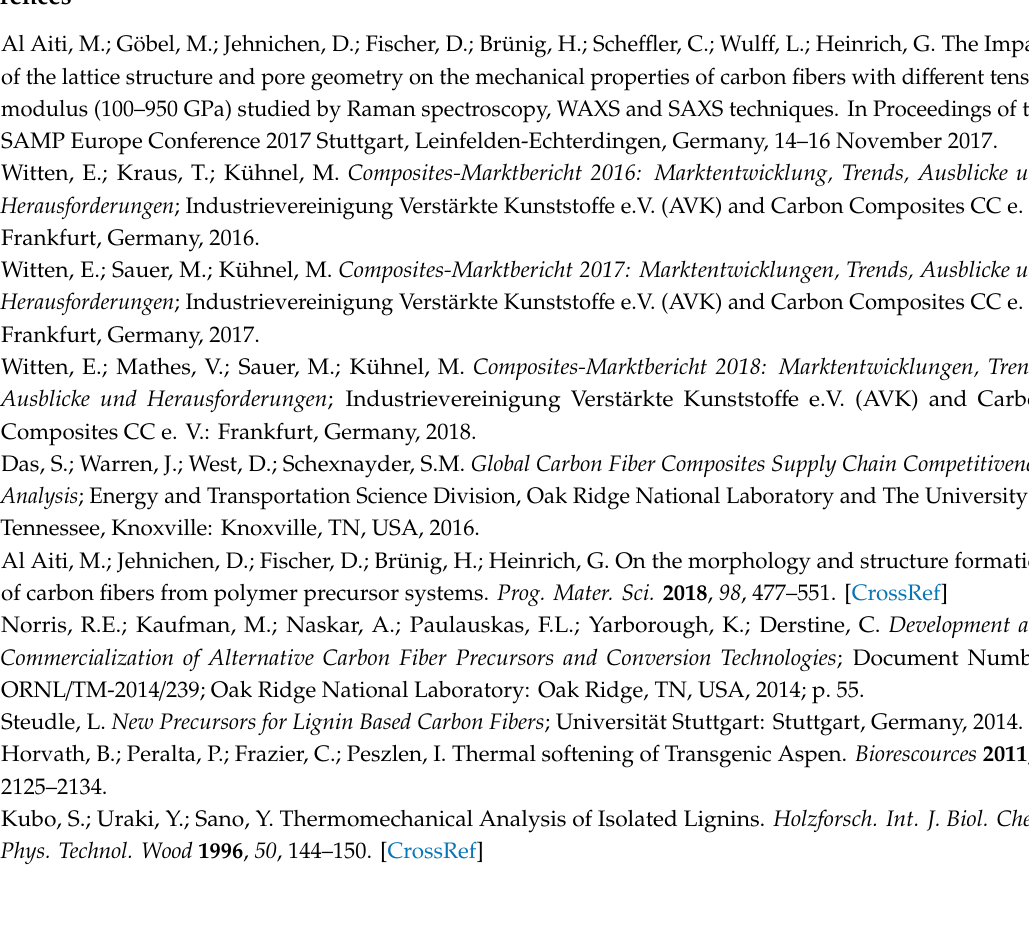
Figure S1: Frequency sweep tests of ( a ) dope ND; ( b ) dope L1; ( c ) dope L2 at di ff erent temperatures., Figure S2: ( a ) Plot of the throughput of the up-scaled spinning dopes ND and L1 versus the rotational speed of the spinning pump; ( b ) the spinnability chart of the spinning dope ND and ( c ) the spinnability chart of the spinning dope L1 (round green circles mean the system was found to be spinnable; and round tacked red circles for un-spinnable set-up. Figure S3: DTG curves of ( a ) PAN fibers and ( b ) PAN / lignin fibers (DR = 2) for detailed assignment of the Peak ID 1, 2 and 3 for both fiber types. Figure S4: SEM Images of ( a ) PAN and ( b ) PAN / Lignin fibres (DR = 2); Green rectangles indicate the areas selected for the EDX evaluations of the elemental concentrations of the atoms C, N, O, S and Cl. EDX images of nitrogen ( c ) and ( d ); oxygen ( e ) and ( f ); sulphur ( g ) and ( h ) and chlorine ( k ) and ( l ). Table S1: Structural properties of Softwood BioChoice TM Kraft Lignin and (*) Softwood Kraft Lignin obtained from the black liquor of Spruce + Pine wood and participated via the LignoBoost ®